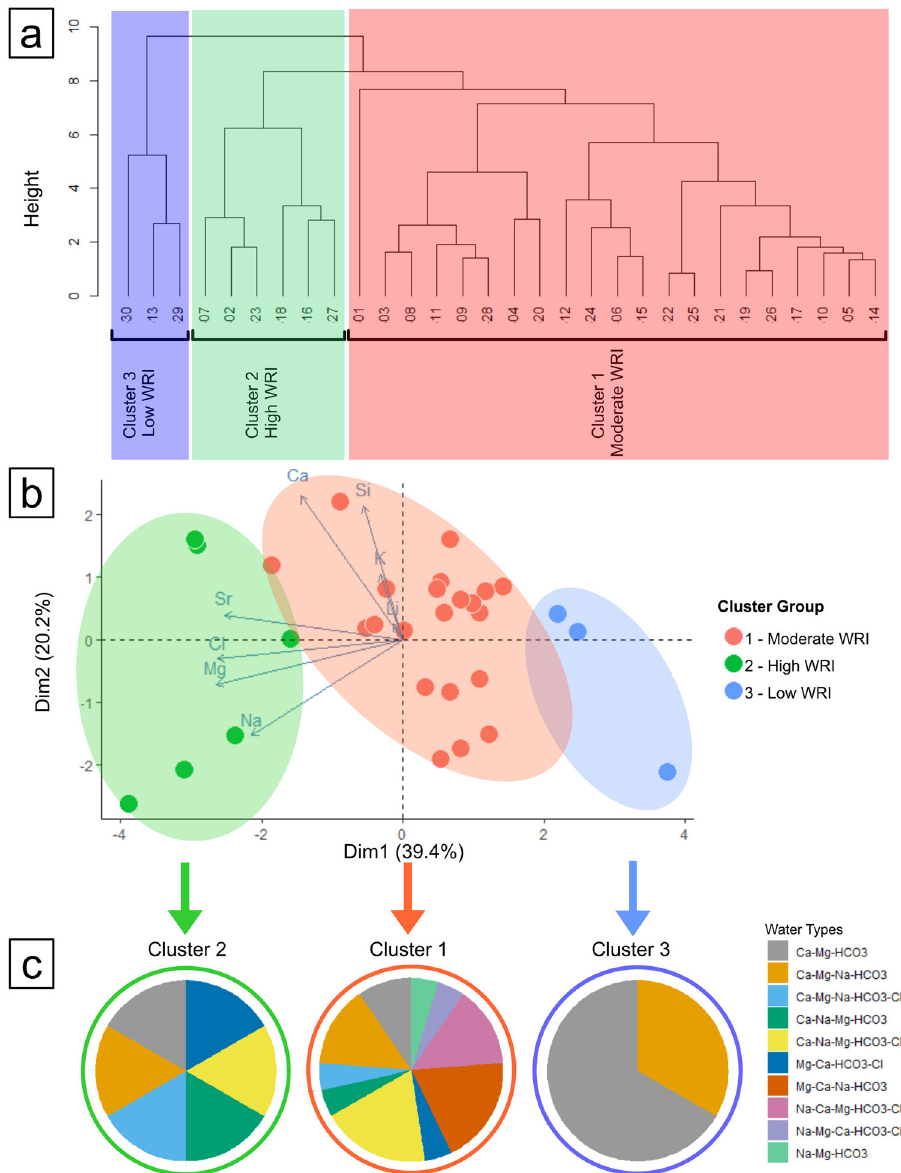
Fig. 1 Water chemistry analysis. a Cluster dendrogram of samples using Sr/Cl, Sr/Na and Li/Na ratios, major ion concentrations (Cl, Na, Ca, Mg and K), Si, Li and Sr concentrations; b PCA biplot using major ions (Cl, Na, Ca, Mg and K), Sr, Li and Si concentrations in mmol L − 1 ; and c pie charts showing the water types for samples in each cluster